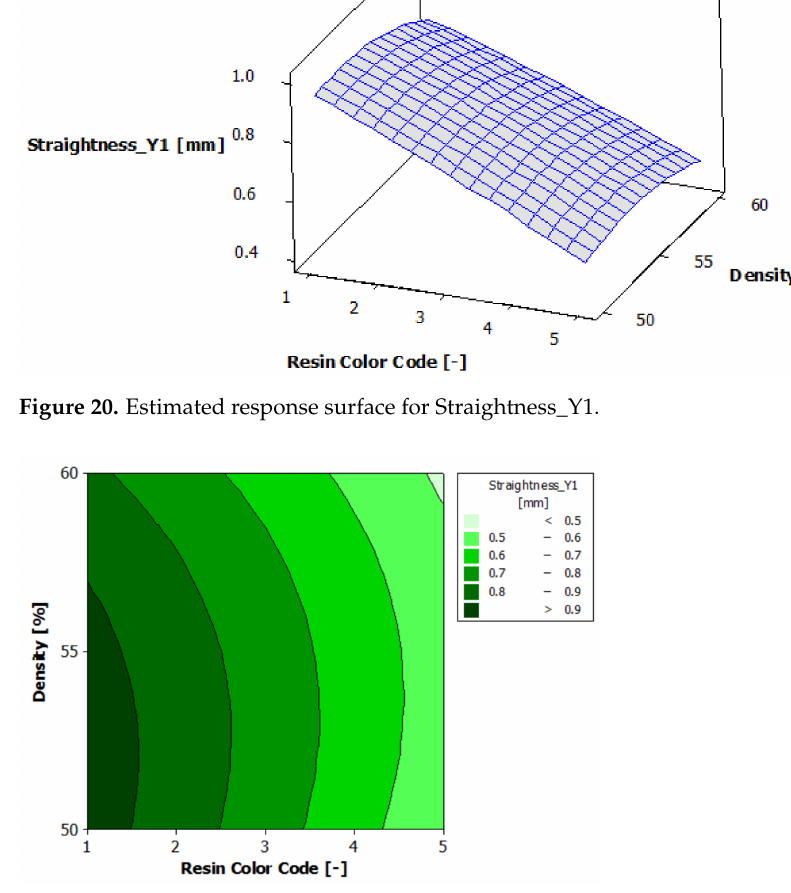
Figure 21. Contours of estimated response surface for Straightness_Y1. Contour